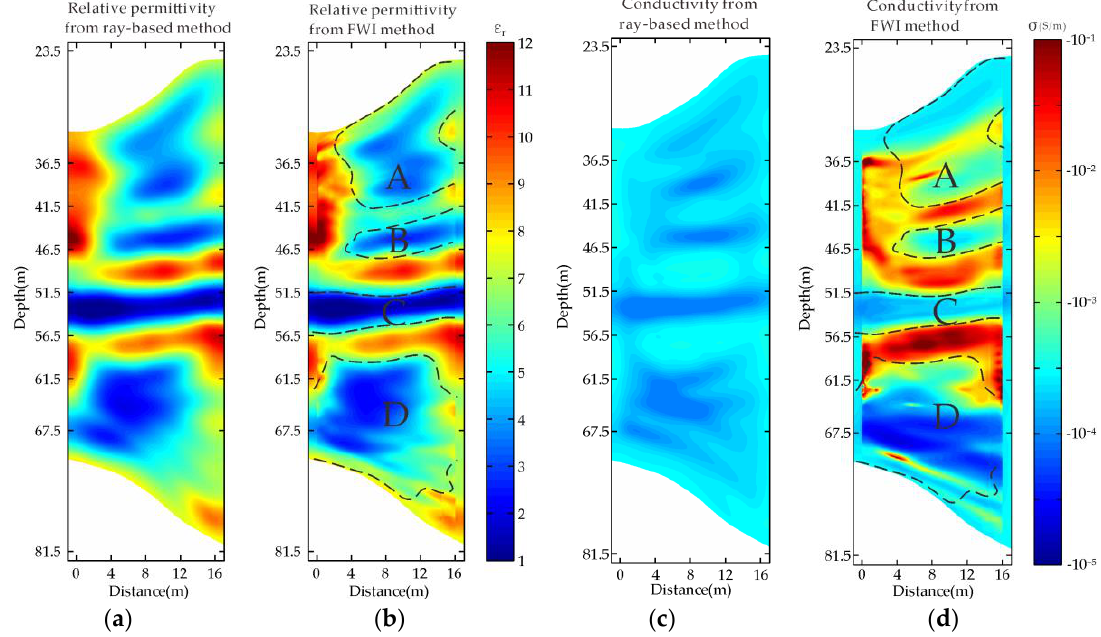
Figure 9. Inverted results of Xiuyan field data: ray-based results of ( a ) relative permittivity and ( c ) conductivity; FWI results of ( b ) relative permittivity and ( d ) conductivity.